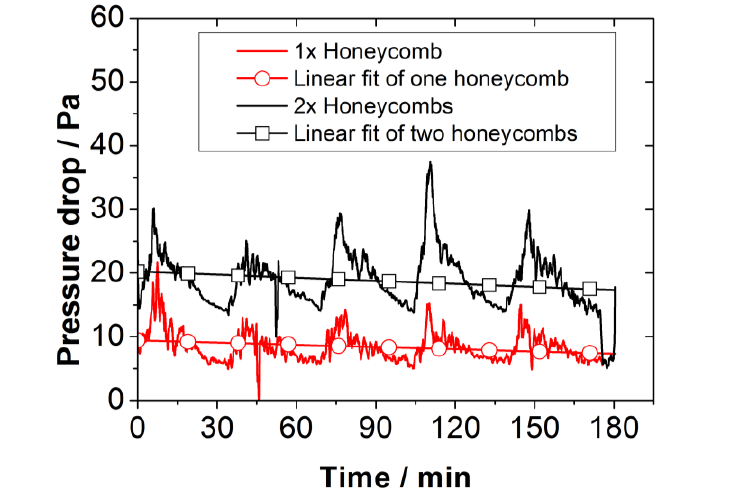
Figure 9. Signal curve and trend (linear fit) for the pressure drop across the one and two honeycomb catalyst units during operation